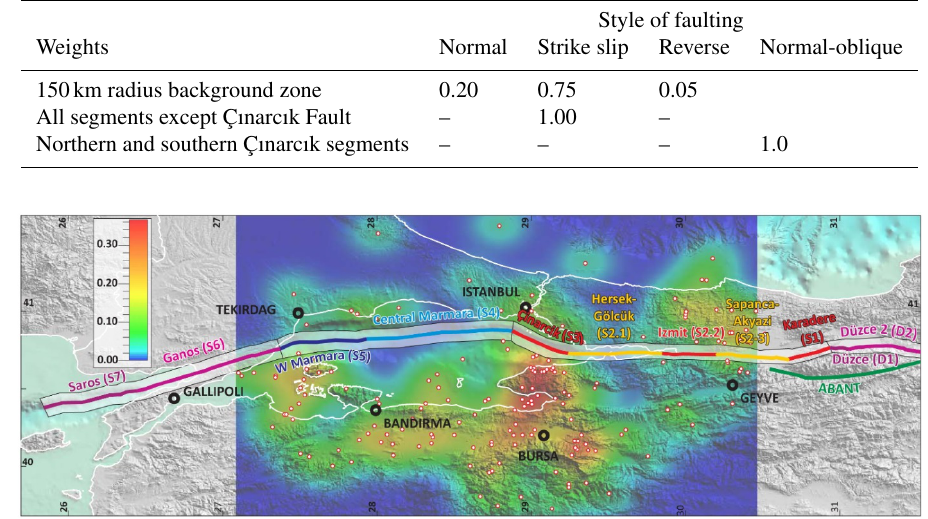
Figure 5. Spatial distribution of the activity rates in the smoothed seismicity source. Red circles are the earthquakes used in the analysis.